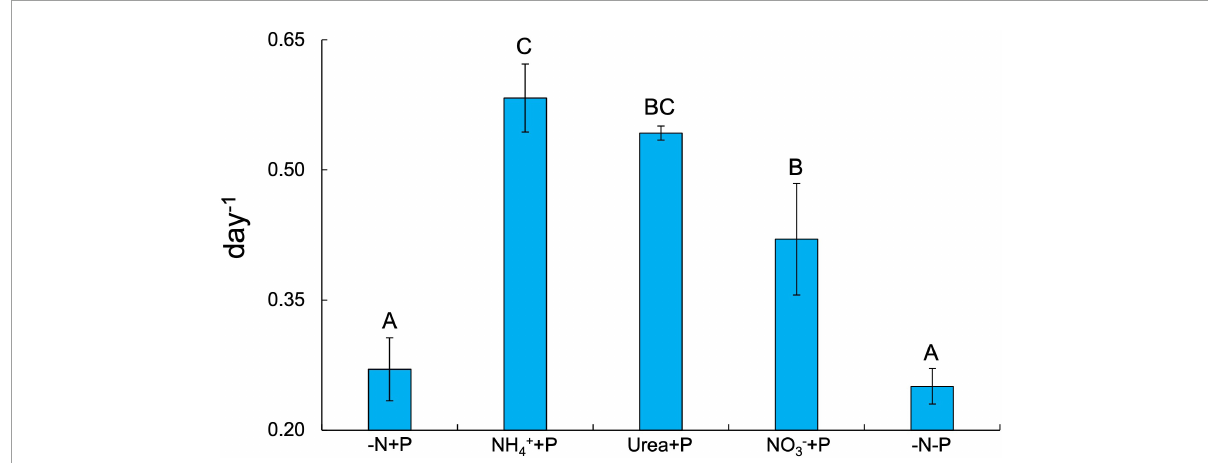
FIGURE1 Maximum growth rates ( µ max ; day − 1 ) across all experimental groups. Error bars represent standard deviation. Letters above bars represent significant differences between experimental groups (Two-way ANOVA; Tukey’s HSD post hoc ; p < 0.05).